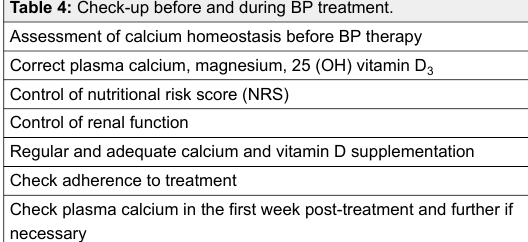
Table 4: Check-up before and during BP treatment.